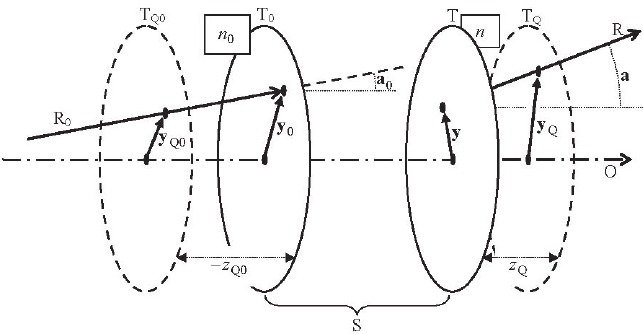
Figure 1 . Ray R R traversing arbitrary linear optical system 0 S. O is its optical axis and T 0 and T its entrance and exit planes respectively. Segment R 0 is incident onto S at 0 y and with in- clination 0 a ; segment R emerges with transverse position y and inclination a . T Q0 and T Q have longitudinal positions 0 0Q < z > z relative to T 0 and T respectively. R 0 intersects T Q0 and 0 Q in transverse position y y and R intersects T Q in Q 0Q